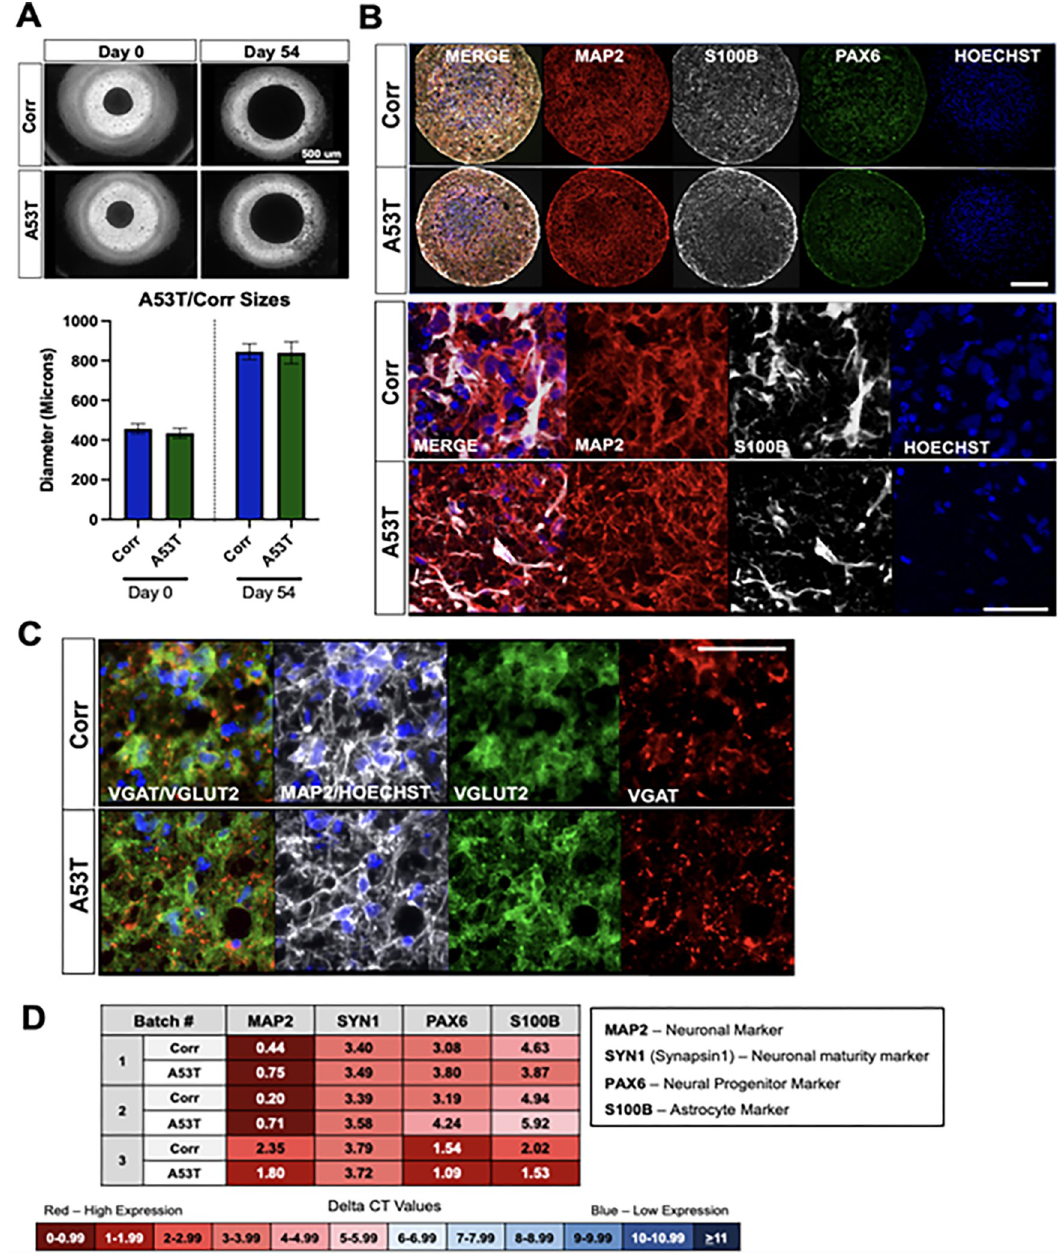
Fig 2. Quality control for A53T/Corr neurosphere differentiations shows cellular subtype composition of cultures. A ) Size difference and variability of neurospheres. Top: Representative phase contrast images of A53T and Corr neurospheres at day 0 and day 54. Bottom: Quantified mean + standard deviation of individual neurospheres across three independent differentiations; n > 20 for all groups. B ) Immunocytochemistry (ICC) of 54-day-neurospheres for neuronal marker MAP2, astrocyte marker S100B, NSC marker PAX6, and Hoechst. Top panel: Whole sphere view of A53T and Corr spheres. Scale bar: 200 μ m. Bottom Panel: Magnified view of MAP2 and S100B positive cells. Scale bar 50 μ m. C ) ICC of 54-day-neurospheres for MAP2, glutamatergic neuron marker VGLUT2, GABAergic neuron marker VGAT, and Hoechst. Scale bar: 50 μ m. D ) Gene expression of MAP2, PAX6, S100B, and Synapsin-I in 54-day-neurospheres for three representative neurosphere differentiations. Each differentiation is a pool of 80–90 neurospheres. Delta CT values, measured by qPCR, are the difference between the CT values of the housekeeping gene (GAPDH) and the gene of interest. A lower CT value (in red) indicates high gene expression, while a high CT value (in blue) indicates low gene